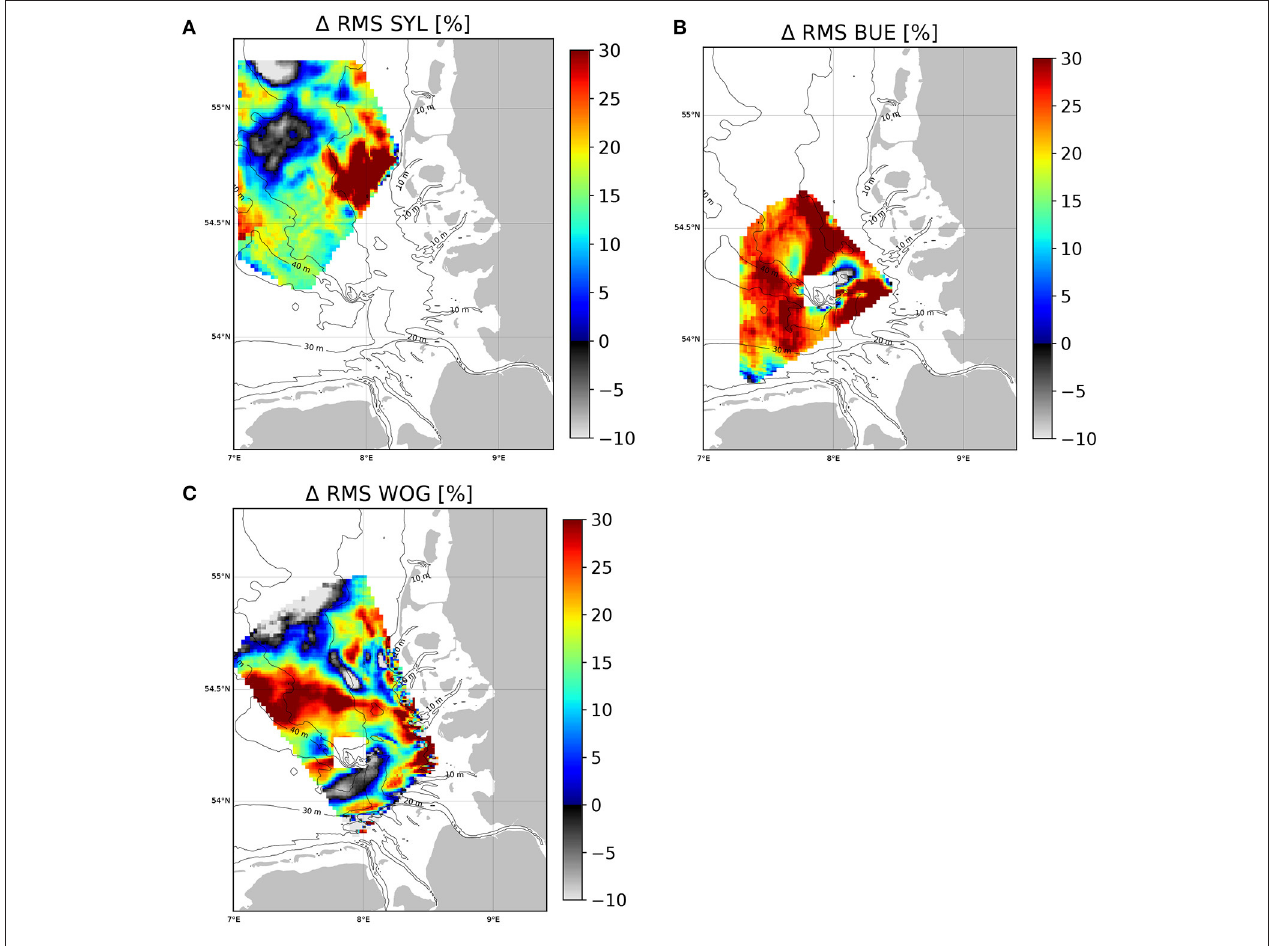
FIGURE 7 | Relative improvements of the radial surface current components achieved with the 4DVAR analysis compared to the BSH model. The percentage values refer to the period May 15–May 29, 2015 and are given for the observations from the Sylt station (A) , the Büsum station (B) , and the Wangerooge station (C)